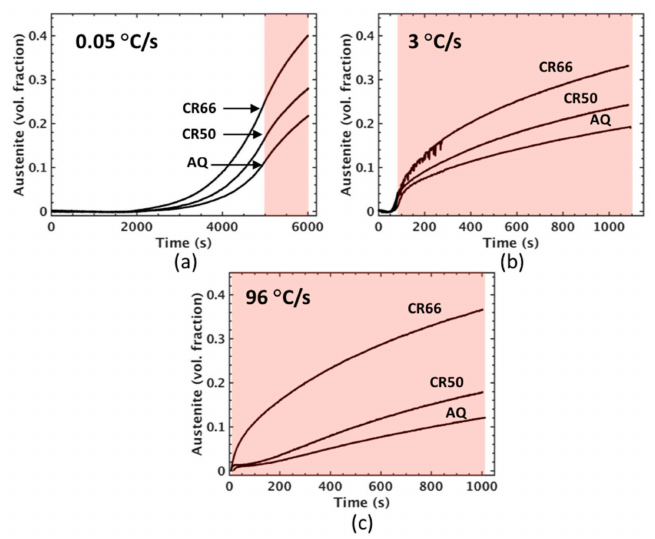
Figure 5. In situ austenite volume fraction assessments from dilatometry for intercritical annealing at 650 ◦ C for each condition and heating rates of 0.05 ◦ C / s ( a ), 3 ◦ C / s ( b ), and 96 ◦ C / s ( c ). Shaded areas indicate approximate duration of isothermal hold at 650 ◦